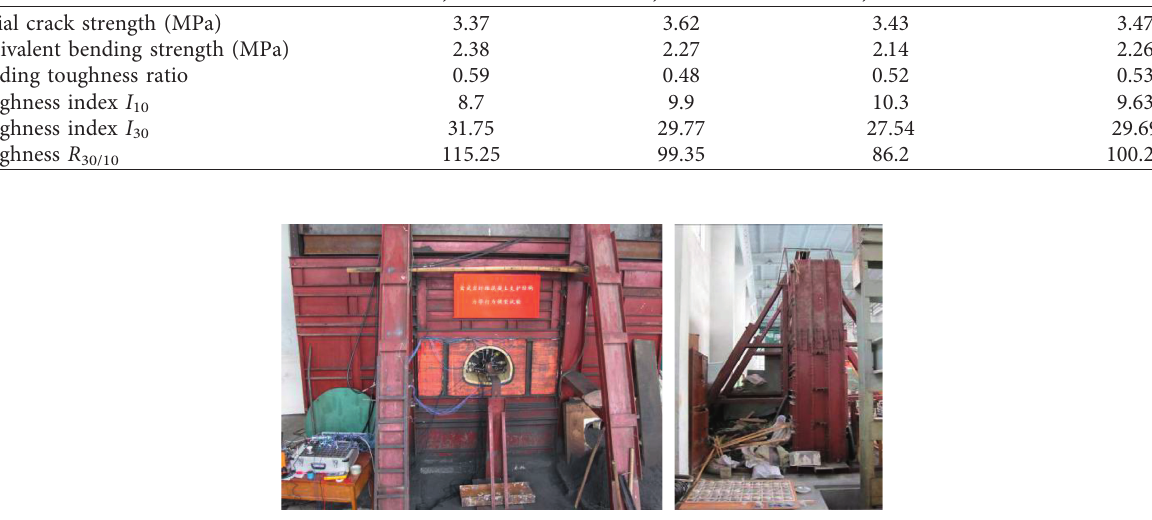
Figure 2: Test platform. Table 5: Similarity ratio of main quantities.